Question: Which kind of chart has been used to present this data?
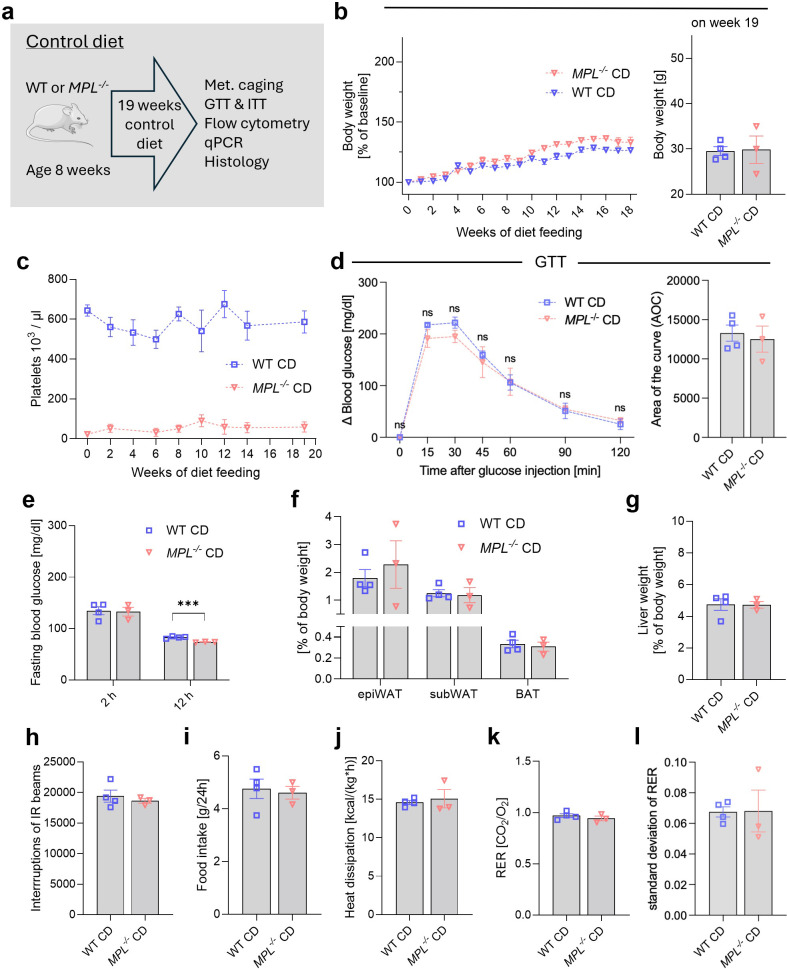
Answer: line